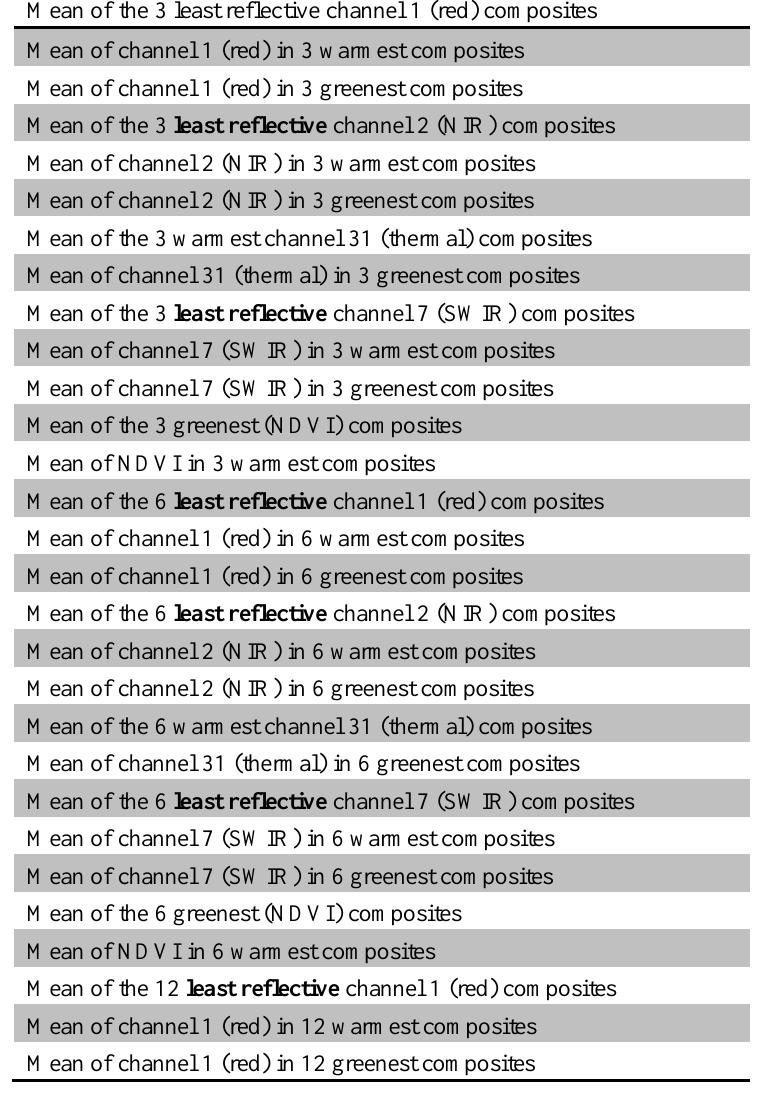
Table 1. MODIS metrics used for mapping global cropland